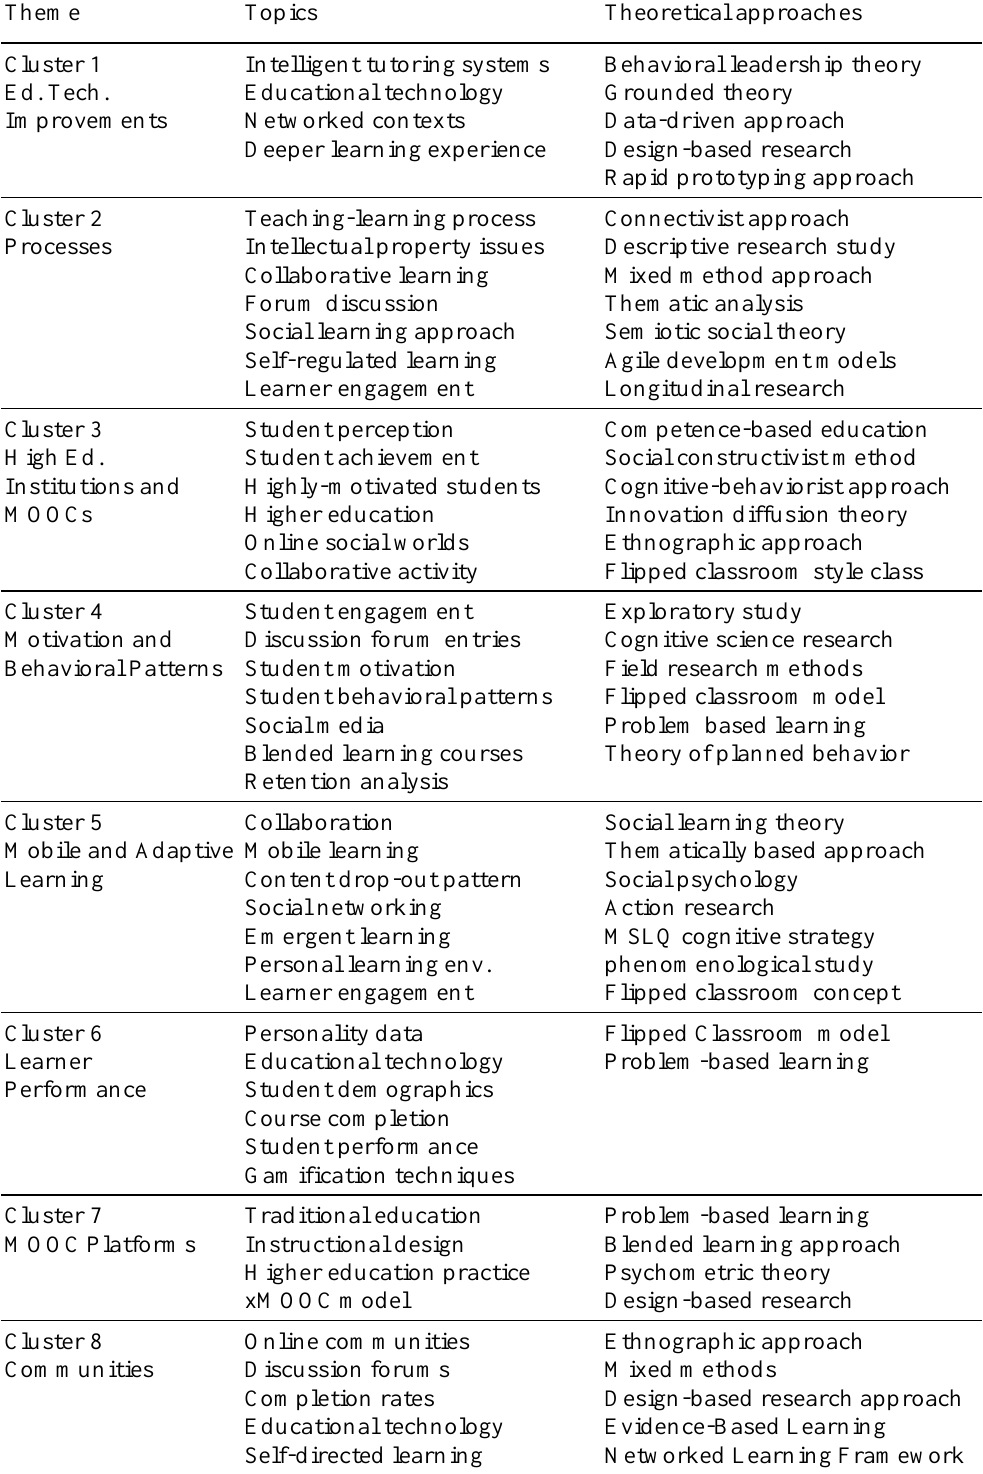
Table 3 Phase 1 Research Themes Topics and Theoretical Approaches